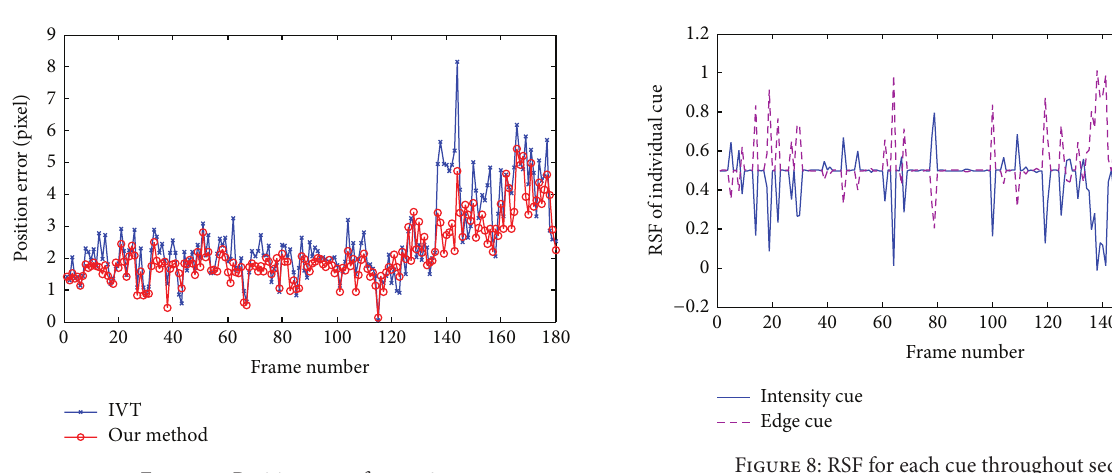
Figure 7: Position error for seq.2.